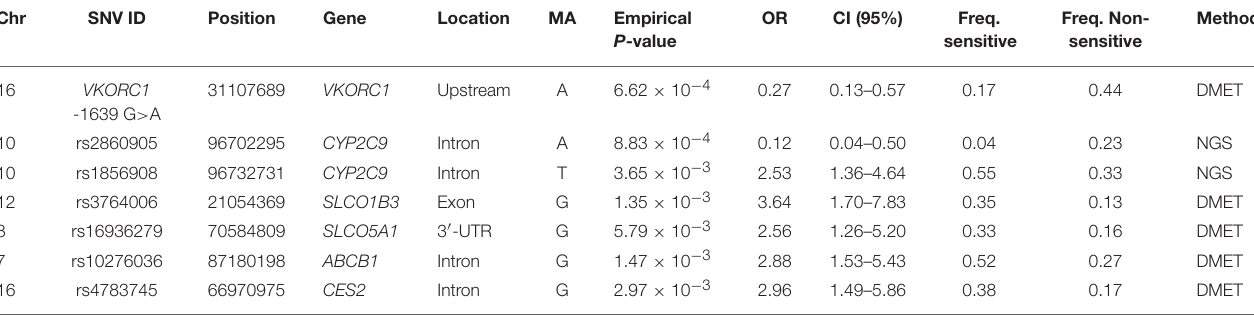
TABLE 3 | SNVs associated with warfarin resistance ( > 6 mg/day). Chr